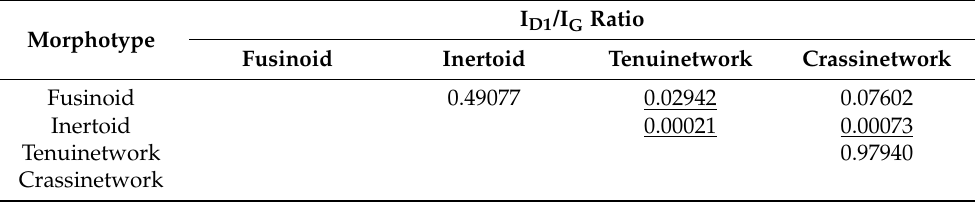
Table 9. Results of the Tukey’s HSD multiple comparison test for the G band FWHM. G Band FWHM Morphotype Fusinoid Inertoid Tenuinetwork Crassinetwork Fusinoid 0.07111 0.00014 0.00014 Inertoid 0.01064 0.00229 Tenuinetwork 0.92636 Crassinetwork